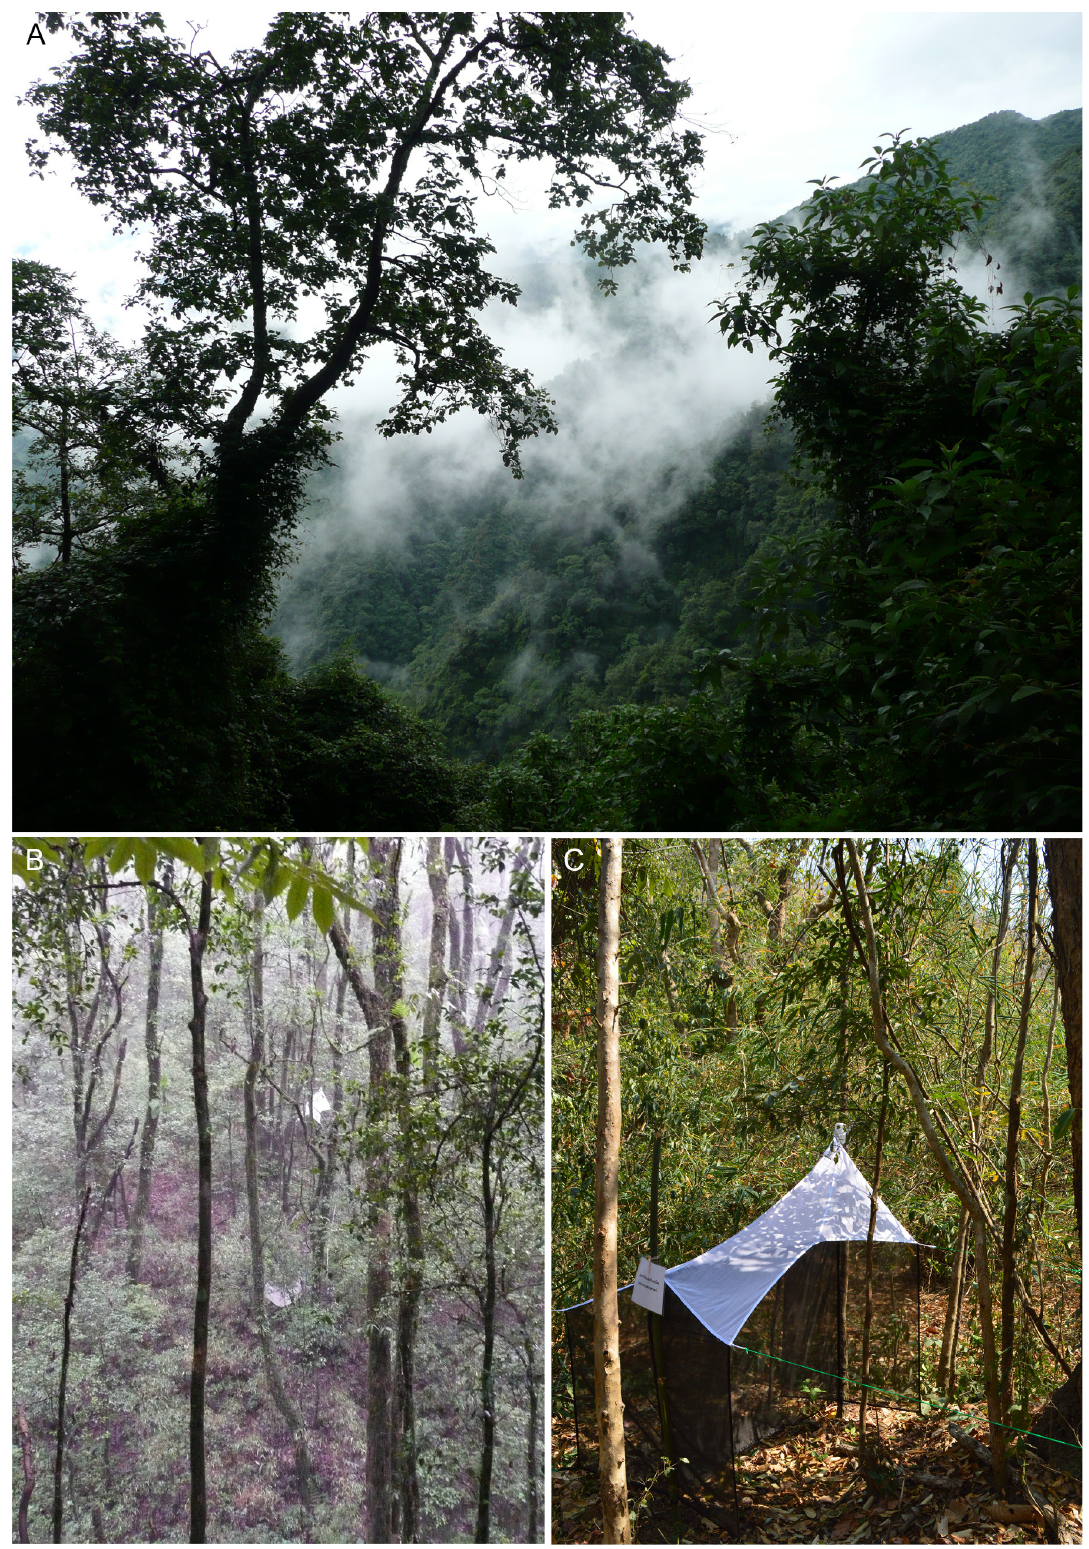
Fig. 2. A . China, Yunnan, Ailao Shan, general view (photo: Akihiro Nakamura). B . Ailao Shan, two traps on the forest floor, habitat of Palpostilpnus aki sp. nov. (photo: Akihiro Nakamura). C . Malaise trap, Thailand, Doi Inthanon National Park, habitat of P. angka sp. nov. (photo: Wichai